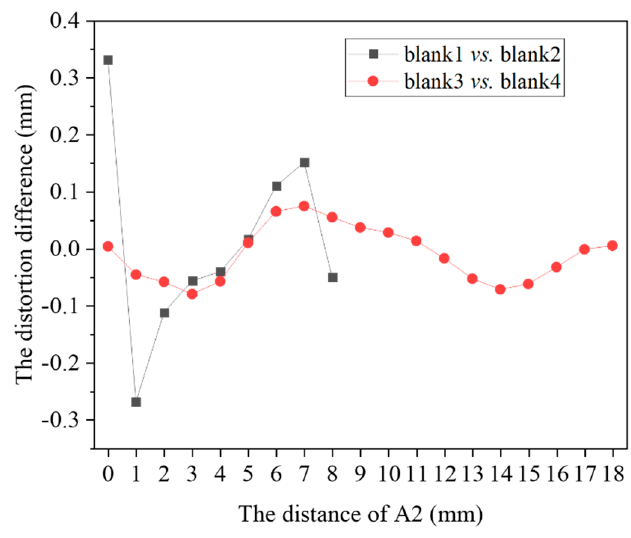
Figure 12. The distortion difference of part 1 in different blanks.